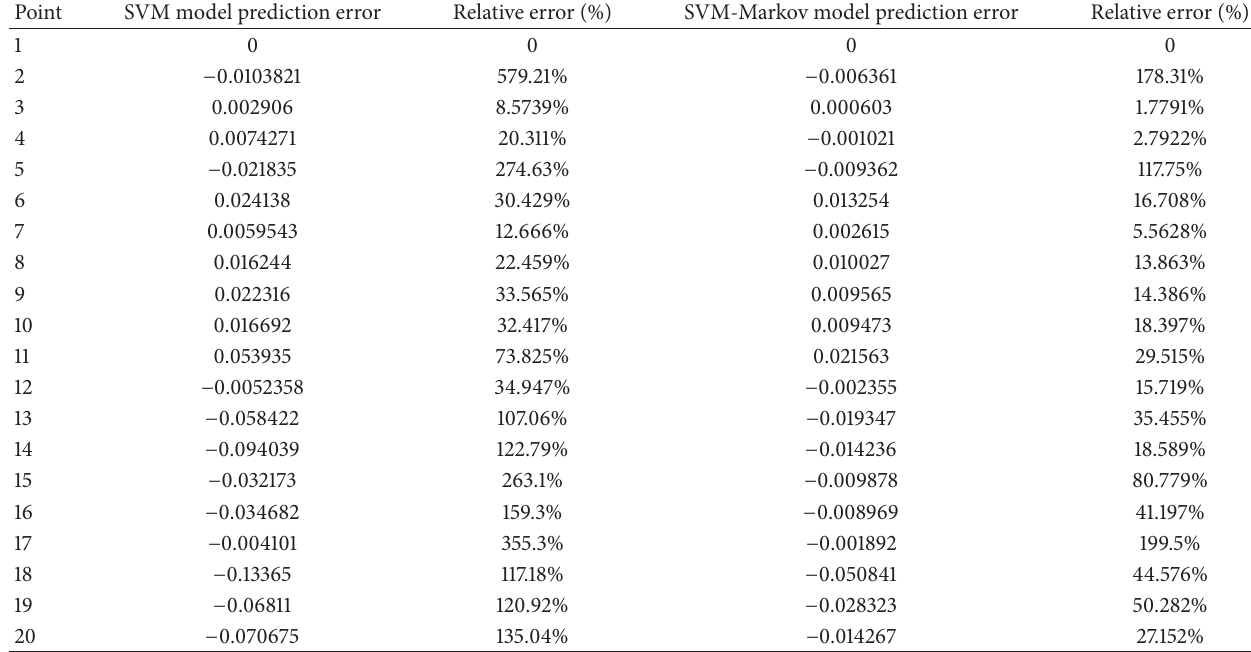
Table 7: The corrected results of the points 1 − 20 based on Markov